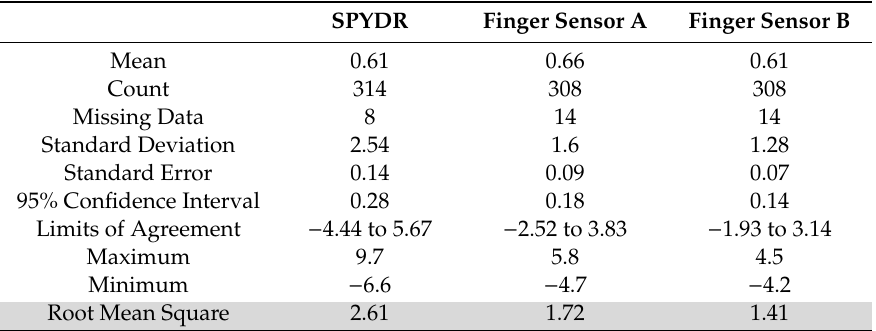
Table 2. Bias for SPYDR (reflectance oximetry) vs. two commercial, FDA-approved finger sensors (Sensor A and B) for 70–100% SaO 2 . All data were independently analyzed and reported by the Hypoxia Research Laboratory at UCSF.